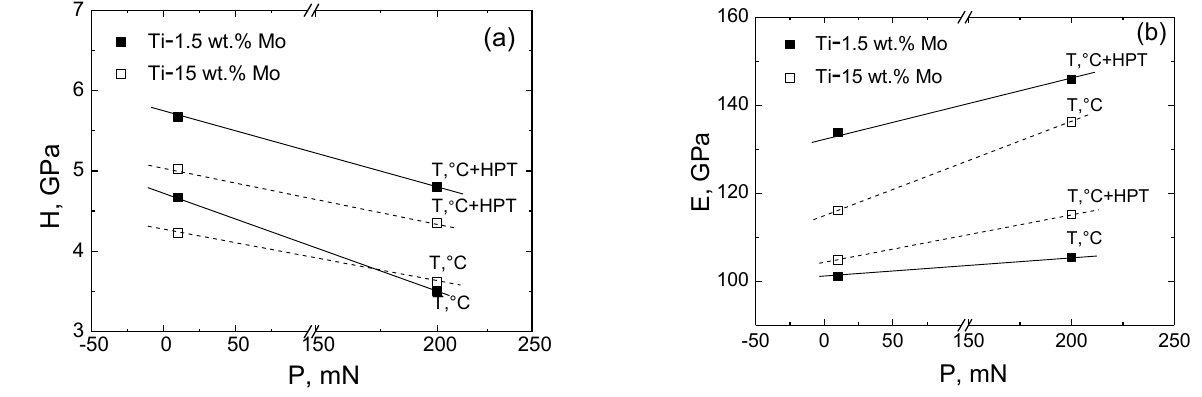
Figure 10. Dependences of hardness H ( a ) and Young’s modulus E ( b ) in the middle of the radius R 1/2 for the samples of Ti–1.5 wt.% Mo and Ti–15 wt.% Mo alloys before and after the HPT. For clarity of tabular data, we present Figure 10. From this figure, it can be seen that HPT leads to a hardening of the material, and the values of nanohardness are higher than equal, the alloy with 1.5 wt.% Mo shows higher hardness values. This fact can be ex-